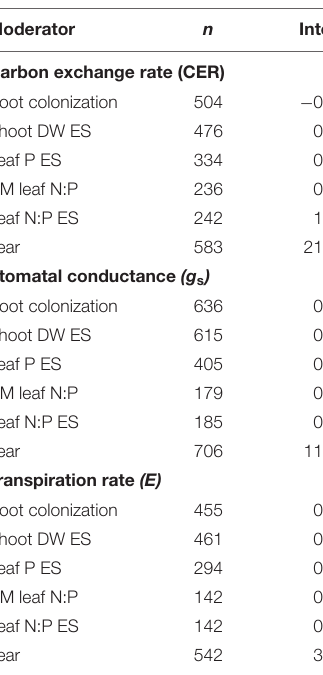
TABLE 2 | Single factor meta-regression.